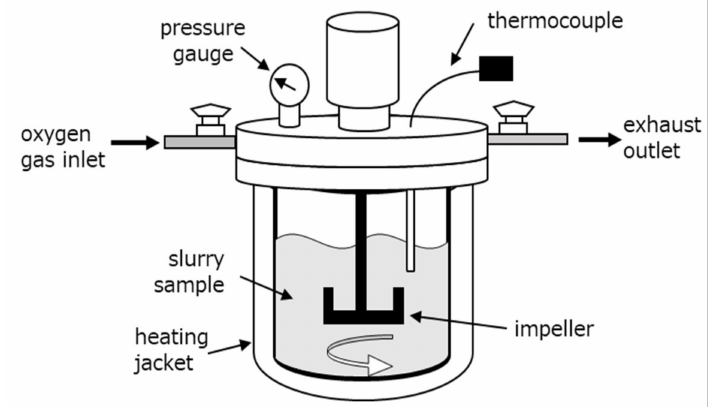
Figure 3. Illustrative setup of an autoclave reactor used for high-pressure oxidative acid